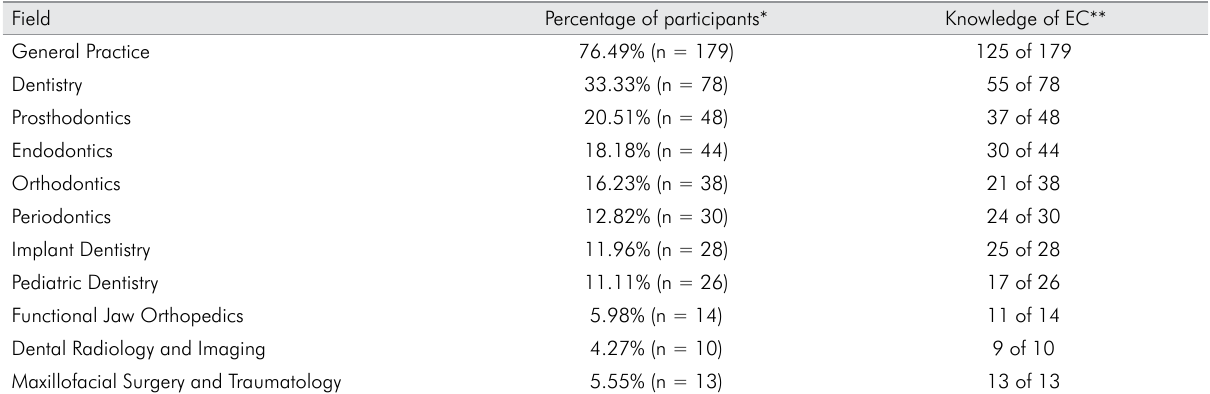
Table 1. Percentage of the sample and numbers of individuals who reported knowledge of EC in each field of